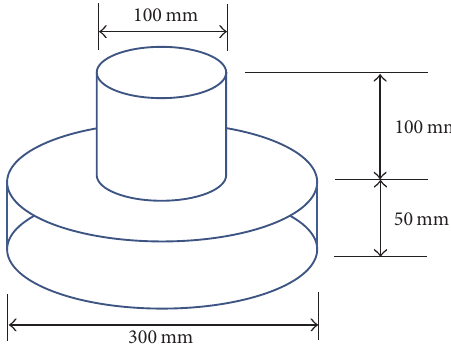
Figure 4: Specimen